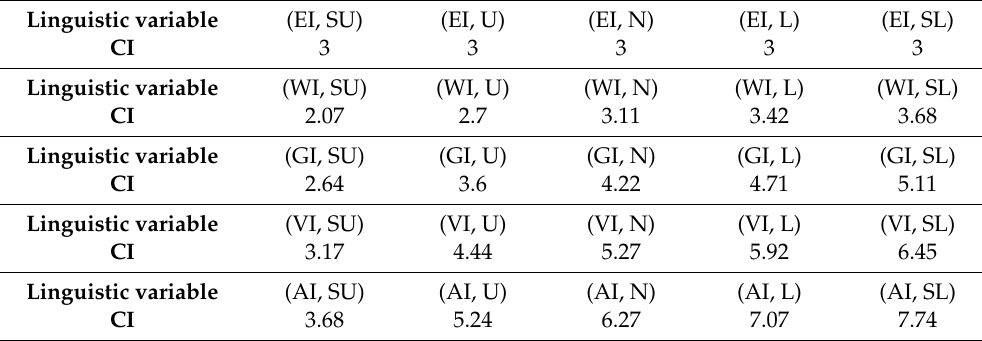
Table 3. Values of the consistency index (CI) for Z-BWM [47].